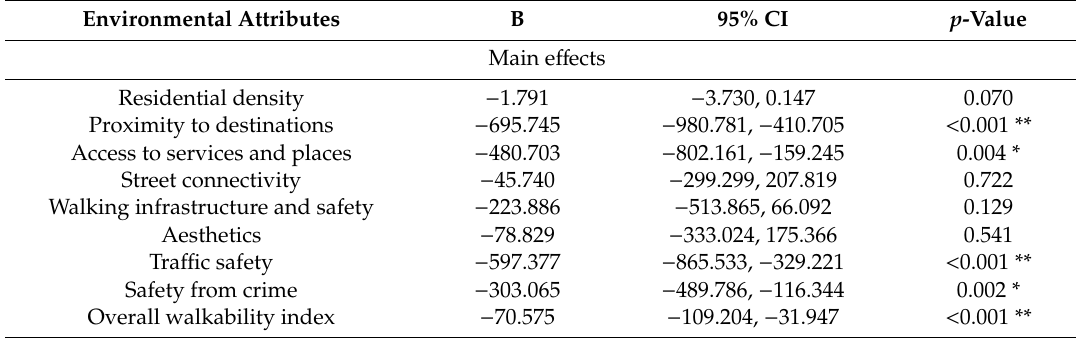
Table 2. Associations between perceived neighborhood environmental attributes and total sedentary time (min /